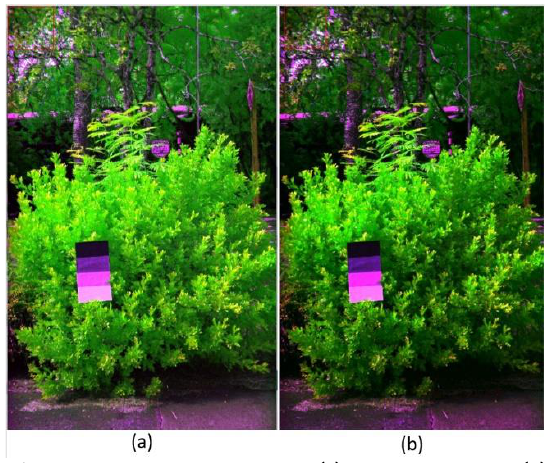
Figure 9. Image taken at 3:30 pm (a) non-calibrated and (b) calibrated radiometrically. False colour composition R(550 nm) G(850 nm) B(450nm).